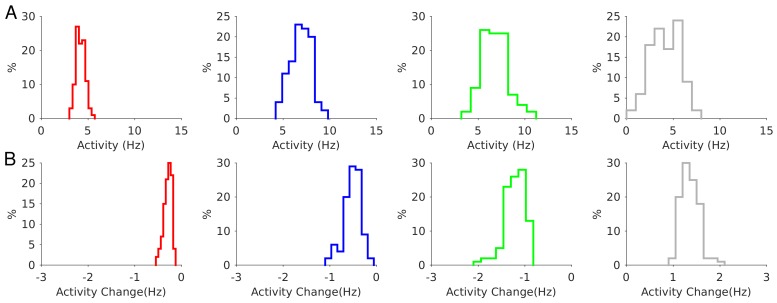
Model 2.Robustness to a change of ±10% in the interaction parameters. (A) Distribution of the population activities. (B) Distribution of the activity changes upon stimulation for Γopto=0.07mW.mm-2. Rates are averaged over 10s. Color code as in Figure 10.